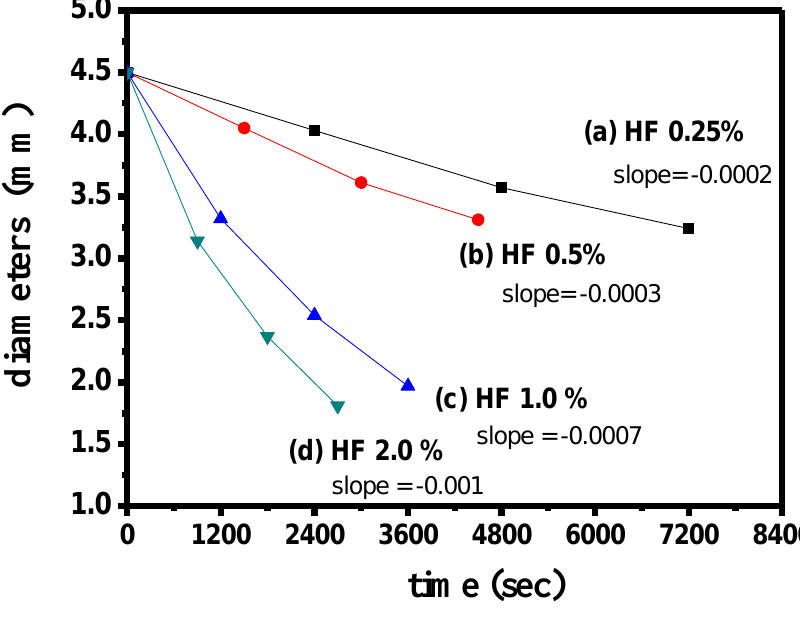
Figure 10. The curves of thickness change versus time, with 4.5-mm SiO various HF concentrations of 0.25%, 0.5%, 1.0% and 2.0%, respectively (the formation of bulk SiO was at R = 10, at pH = 4, after standing for 3 2